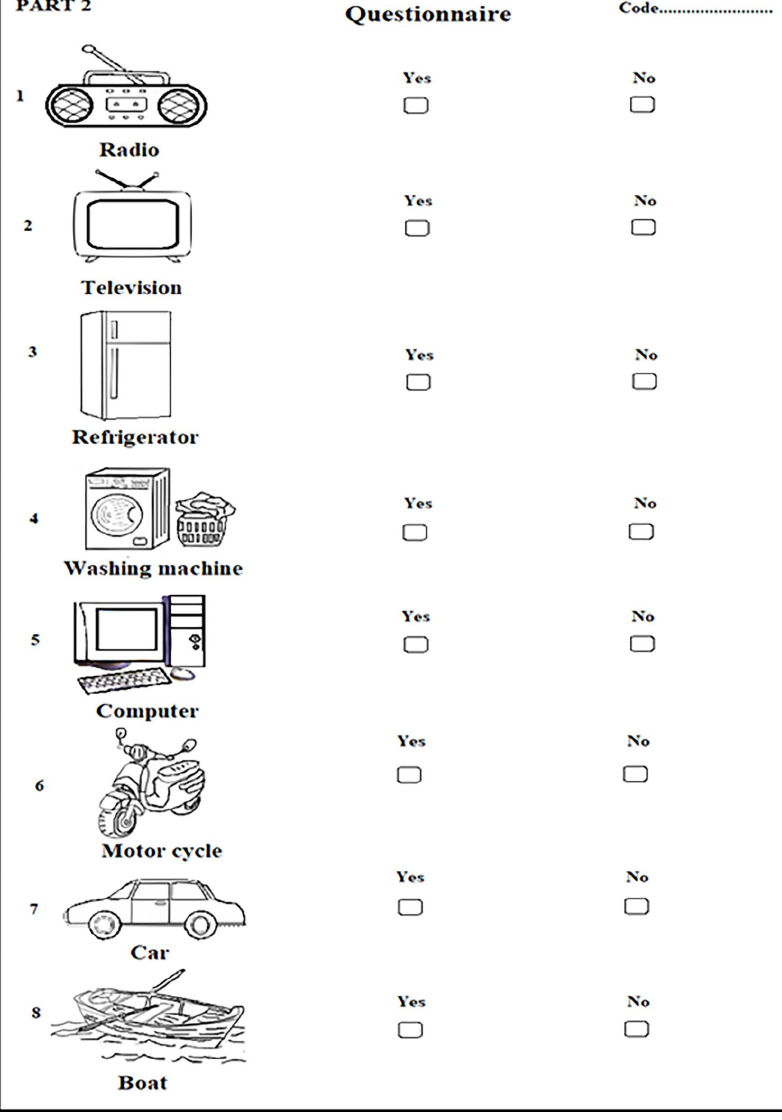
Figure 2. An example of the picture questionnaire used in this study which was used to obtain information on the demographic characteristics, socioeconomic status, and sanitary condition of